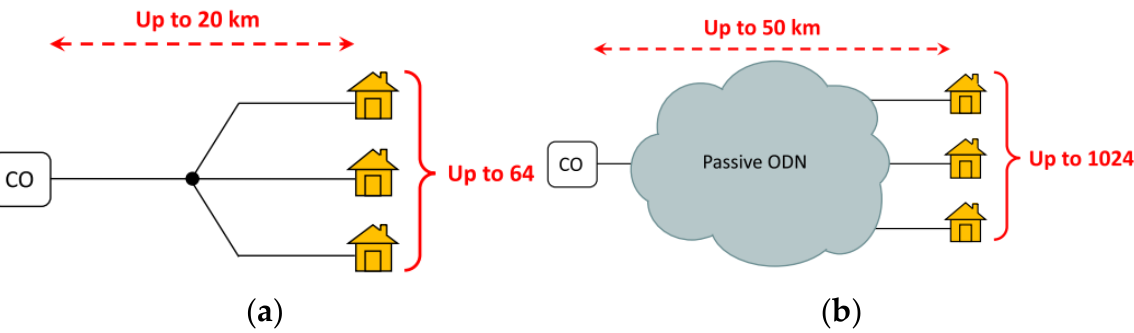
Figure 17. Scalability and reach of ( a ) typical PON and ( b ) super-PON [56].